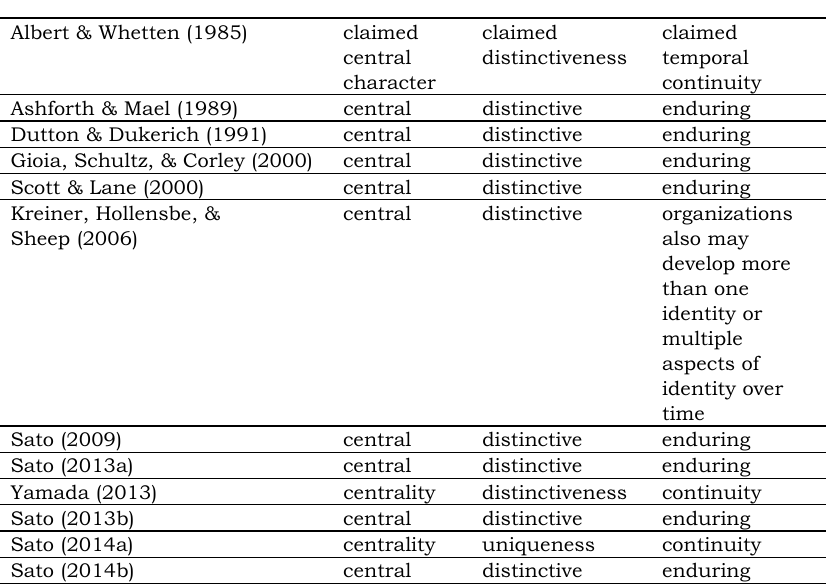
Table 1. Subsequent expressions of the three criteria cited from Albert and Whetten